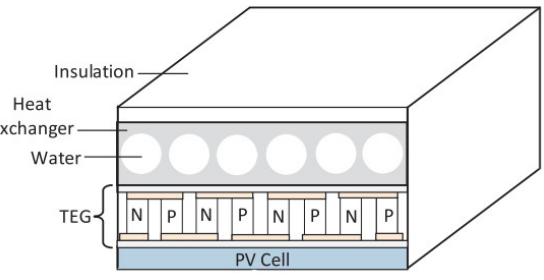
Figure 19. Schematics of the receiver of the CPVT-TE [15]. Reprinted with permission from Ref. [15]. 2020, Elsevier.